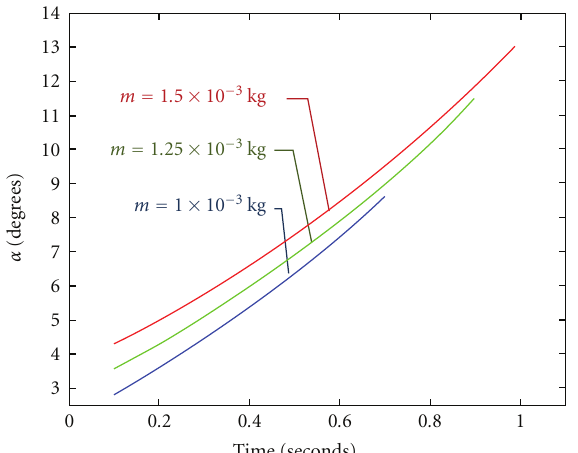
Figure 7: Dragonfly gliding straight—changing the wing area. Velocity versus time.